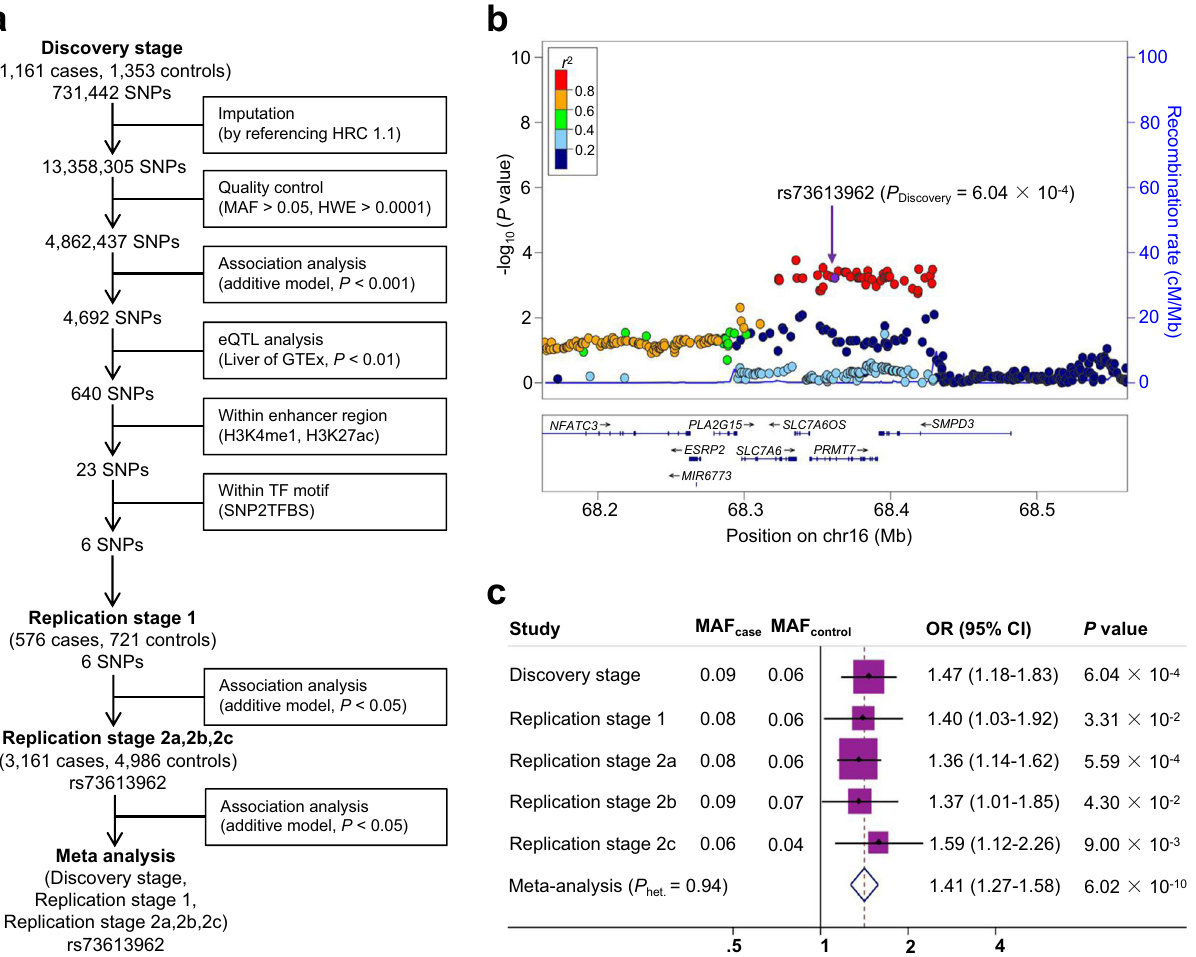
Fig. 1 A candidate enhancer variant rs73613962 is screened and validated to be signi fi cantly associated with HCC risk. a Flowchart shows the candidate single-nucleotide polymorphisms (SNPs) in enhancers selected from the discovery stage and validated in two stages of replication. HRC Haplotype Reference Consortium, MAF minor allele frequency, HWE Hardy-Weinberg equilibrium, eQTL expression quantitative trait loci, TF transcription factor. b Regional association plot shows the association results ( − log 10 P ) of all the SNPs in the region 100 kb upstream and 100 kb downstream of PRMT7 rs73613962 in Discovery stage ( n = 1161 cases, n = 1353 controls). The association of each SNP with HCC risk was evaluated through logistic regression under an additive model adjusting for gender and age. As the index SNP, rs73613962 is shown in purple, and the r 2 values of the remaining SNPs are indicated by color. The genes within the region are annotated and shown as arrows. c The meta forest plot shows the association results of rs73613962 in the fi ve independent populations of the discovery stage, replication stage 1, and replication stages 2a, 2b, and 2c. The association of rs73613962 with HCC risk in each population was calculated through logistic regression under an additive model adjusting for gender and age. The MAFs in cases and controls are shown for each population. The ORs and 95% CIs were calculated by considering the major allele as a reference. The center of each square and the horizontal line show the OR and the corresponding 95% CI, respectively. The pooled OR was obtained using the fi xed-effects model and is represented by a hollow diamond, where its center indicates the OR and its ends correspond to the 95%